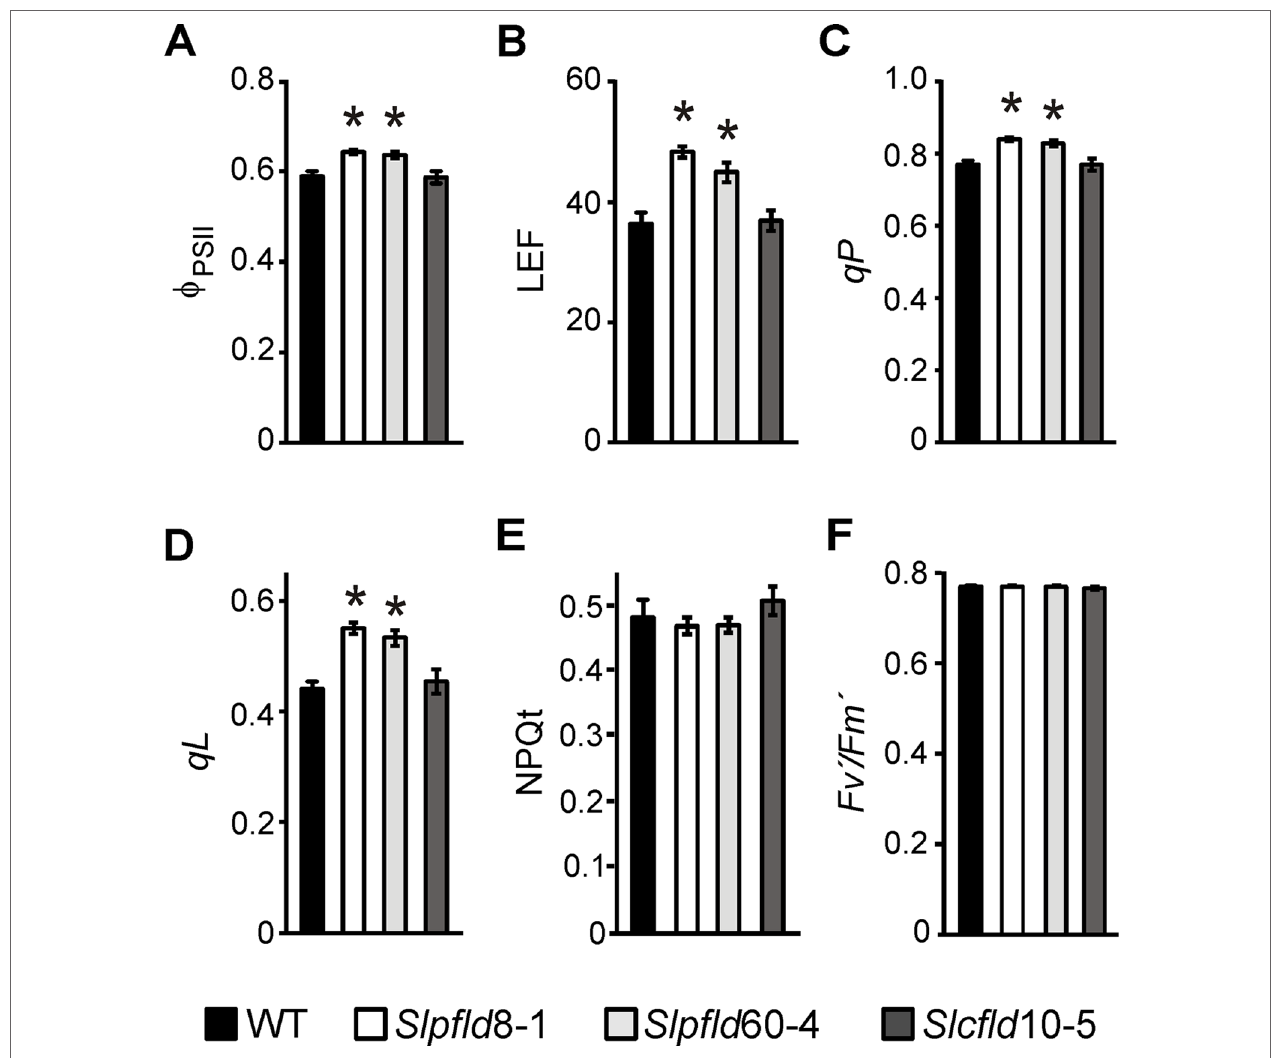
FIgURE 3 | Tomato leaves expressing chloroplast flavodoxin exhibited higher photosynthetic activities. Measurements of quantum yield of photosystem (PS) II ( ϕ PSII , A ), rate of linear electron transport (LEF, B ), photochemical quenching ( qP , C ), fraction of open PSII reaction centers ( qL , D ), non-photochemical quenching (NPQt, E ), and PSII integrity ( F v ′ / F m ′ , F ) were carried out in the third leaflet of the fourth fully expanded leaf of plants at 45 days post-germination. They correspond to the means ± SEM of six biological samples with six technical replicates each. Statistical differences between wild-type and transgenic lines are indicated by asterisks and were determined using one-way ANOVA and Tukey's multiple comparison test ( P <